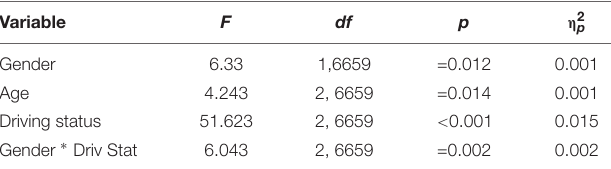
TABLE 6 | Significant results for the three between groups variables on